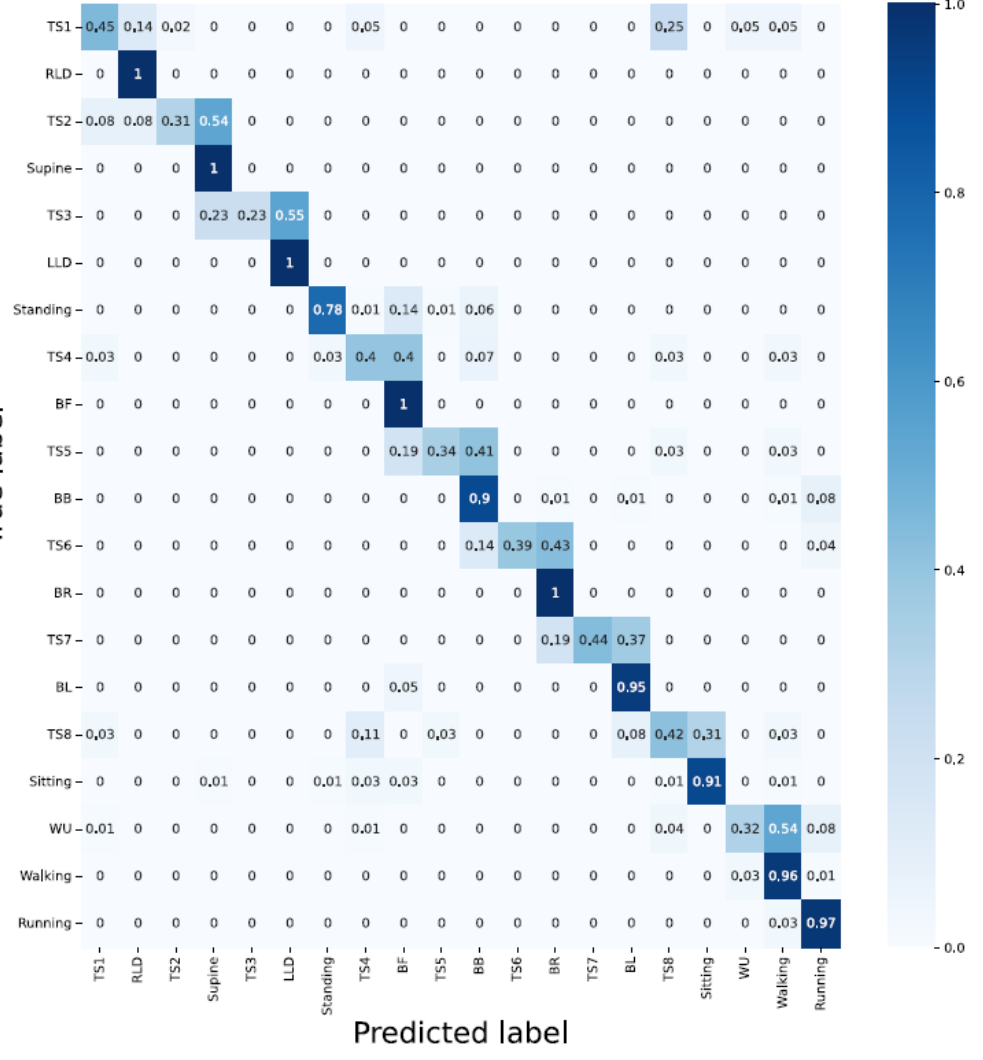
Figure 15. A hybrid architecture with two-second window delivers error-free results regarding lying down-associated positions activities and BR and BF. Table 3. Data fusion in LSTM architecture yielded a promising output for fall detection using the felx